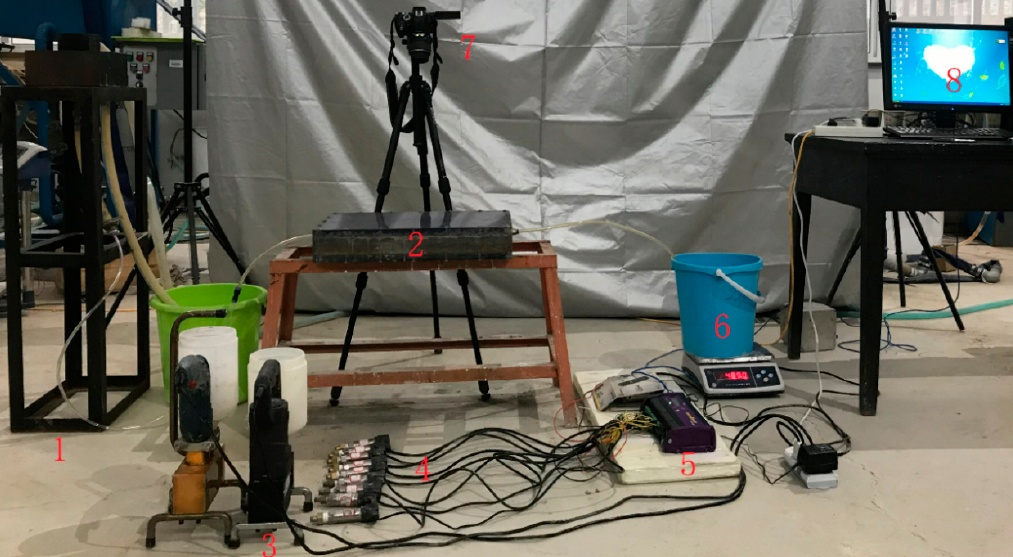
Figure 6. Picture of the experimental device. 1—Stable water head system; 2—the simulated fracture;